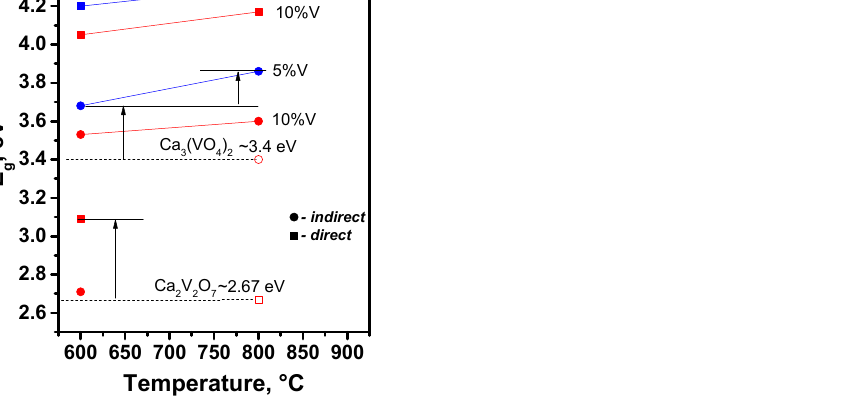
Figure 7. The energy gap width E g values (direct and indirect allowed transitions) for 5%V/C12A7 (blue) and 10%V/C12A7 (red) in comparison with the experimental data for Ca 3 (VO 4 ) 2 ( ○ ) [60] and Ca 2 V 2 O 7 ( □ ) [44].